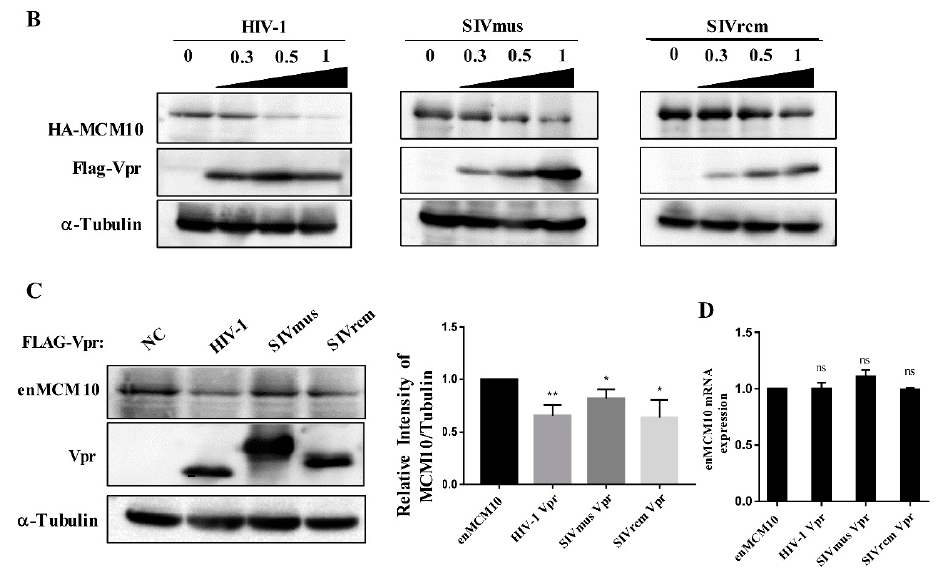
Figure 2. Downregulation of exogenous and endogenous MCM10 by HIV-1, SIVmus, and SIVrcm among 11 primate lentiviruses Vpr/x. ( A ) Downregulation of exogenous MCM10 by 11 primate lentiviruses Vpr/x. HEK293T cells were transiently transfected with pcDNA 3.1/HA-MCM10 together with either pcDNA3.1/3 × FLAG-HIV/SIV Vpr/x, or the control pcDNA3.1/3 × FLAG (NC: negative control). Transfected cells were harvested at 48 h after transfection and lysates with the equal protein amounts were subjected to western blotting with anti-FLAG mouse monoclonal antibodies (mAb), anti-HA mouse mAb, anti-Tubulin mouse mAb (upper panel). The positions of 3 × FLAG-Vpr/x, HA-MCM10 and α -Tubulin are indicated. Band densities of HA-MCM10 and α -Tubulin were quantified by densitometry analysis using ImageJ software. The relative intensities were calculated as the ratio of density of MCM10 to density of α -Tubulin. Each column and error bar represents the mean ± SD of three independent experiments (under panel). ( B ) A dose-dependent manner of downregulation of exogenous MCM10 by HIV-1, SIVmus, and SIVrcm Vprs. HEK293T cells were transiently transfected with pcDNA 3.1/HA-MCM10 together with 0, 0.3, 0.5, or 1.0 μ g of either pcDNA3.1/3 × FLAG-HIV-1, SIVmus or SIVrcm Vprs. The positions of 3 × FLAG-Vpr/x, HA-MCM10 and tubulin are indicated (upper panel). ( C , D ) Downregulation of endogenous MCM10 protein by HIV-1, SIVmus, and SIVrcm at protein level. HEK293T cells were transiently transfected with either pcDNA3.1/3 × FLAG-HIV-1, SIVmus, or SIVrcm Vprs, or the control pcDNA3.1/3 × FLAG (NC: negative control). After 48 h, endogenous MCM10 protein was examined using western blotting with anti-MCM10 rabbit polyclonal antibodies, anti-FLAG mouse mAb, and anti-Tubulin mouse mAb ( C ), and MCM10 mRNA expression was evaluated using Real-time qRT-PCR analysis ( D ). ( C ) The positions of 3 × FLAG-Vpr, endogenous MCM10 and α -Tubulin are indicated. Band densities of endogenous MCM10